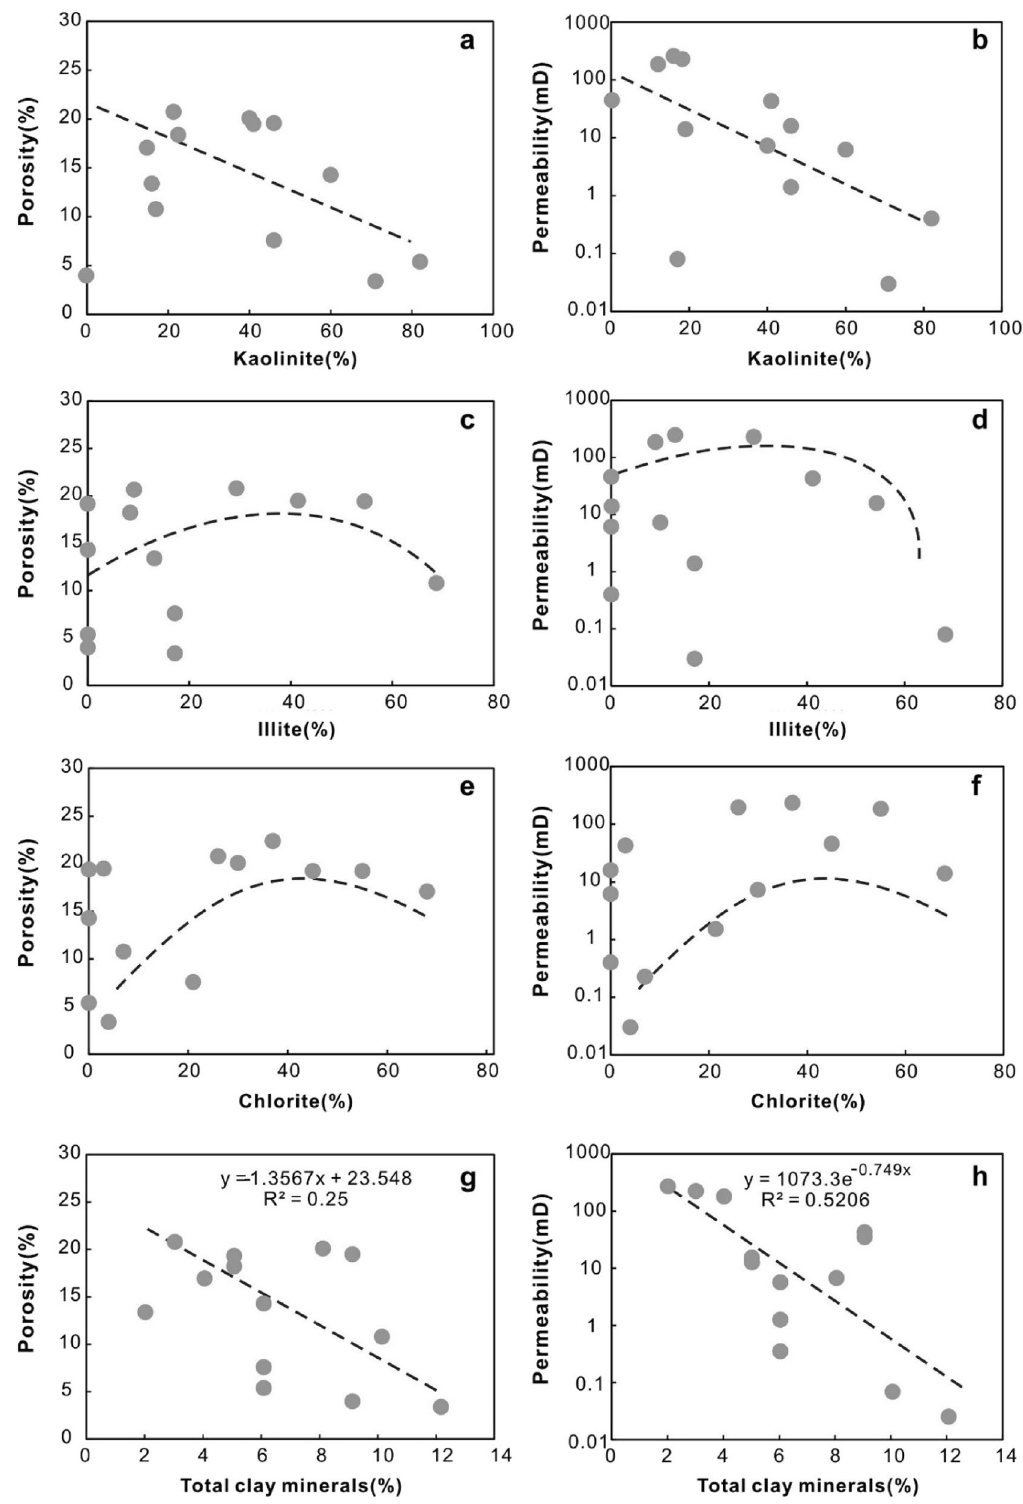
Figure 13. Variations in the relative content of kaolinite ( a,b ), illite ( c,d ), chlorite ( e,f ) and total content of clay minerals ( g,h ) with the porosity and permeability. The relative mineralogical composition of each clay minerals was quantitatively analyzed via X-ray diffraction